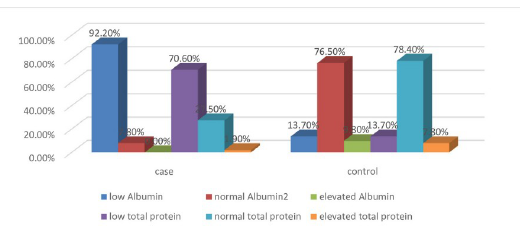
Fig 2. Evaluation of categorical value of serum albumin and serum total protein among the study